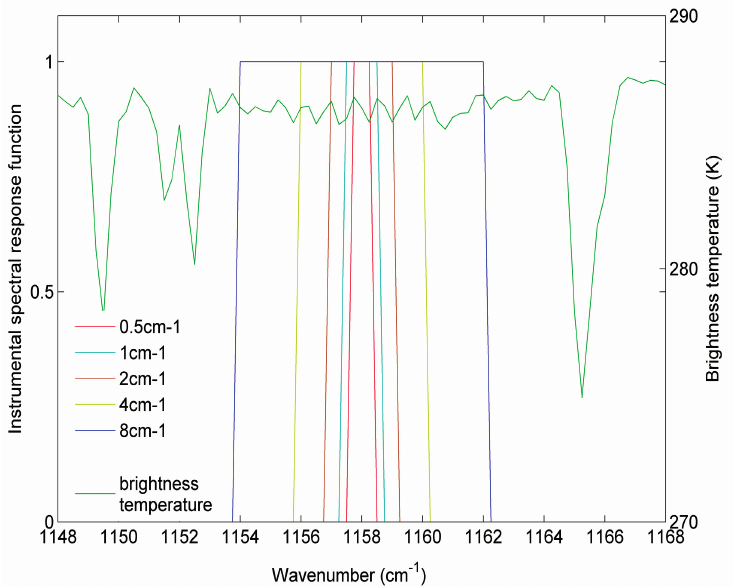
Figure 7. The five ISRFs at the channel with the centre wavenumber = 1158 cm − 1 superimposed on one typical IASI spectrum in the spectral interval of 1148–1168 cm − 1 .